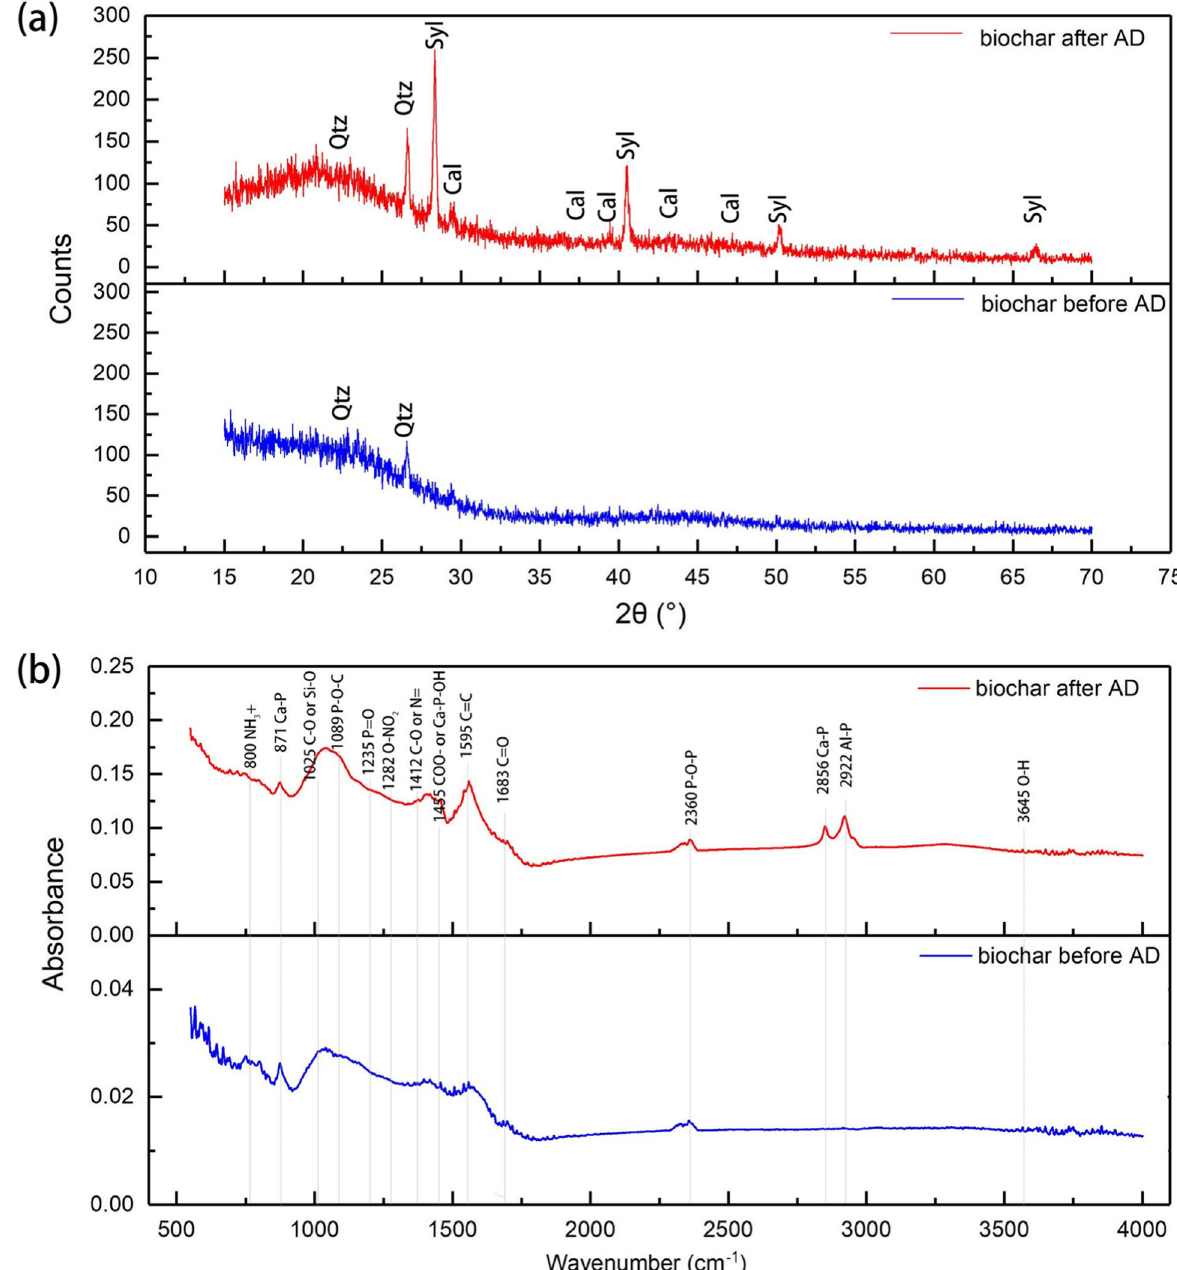
Fig. 7 XRD patterns ( a ) of biochars before and after AD. Peaks of quartz (Qtz), calcite (Cal), sylvite (Syl) in XRD spectra are designated, and FTIR-ATR spectra ( b ) of biochars before and after AD. Major peaks of different functional groups are